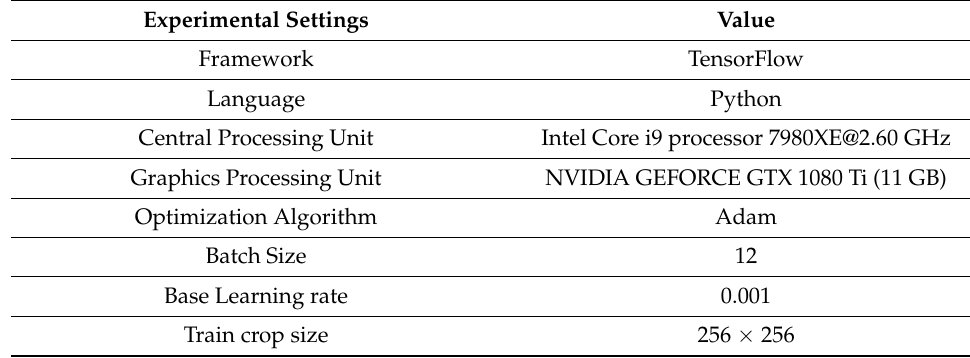
Table 1. Experimental Settings.